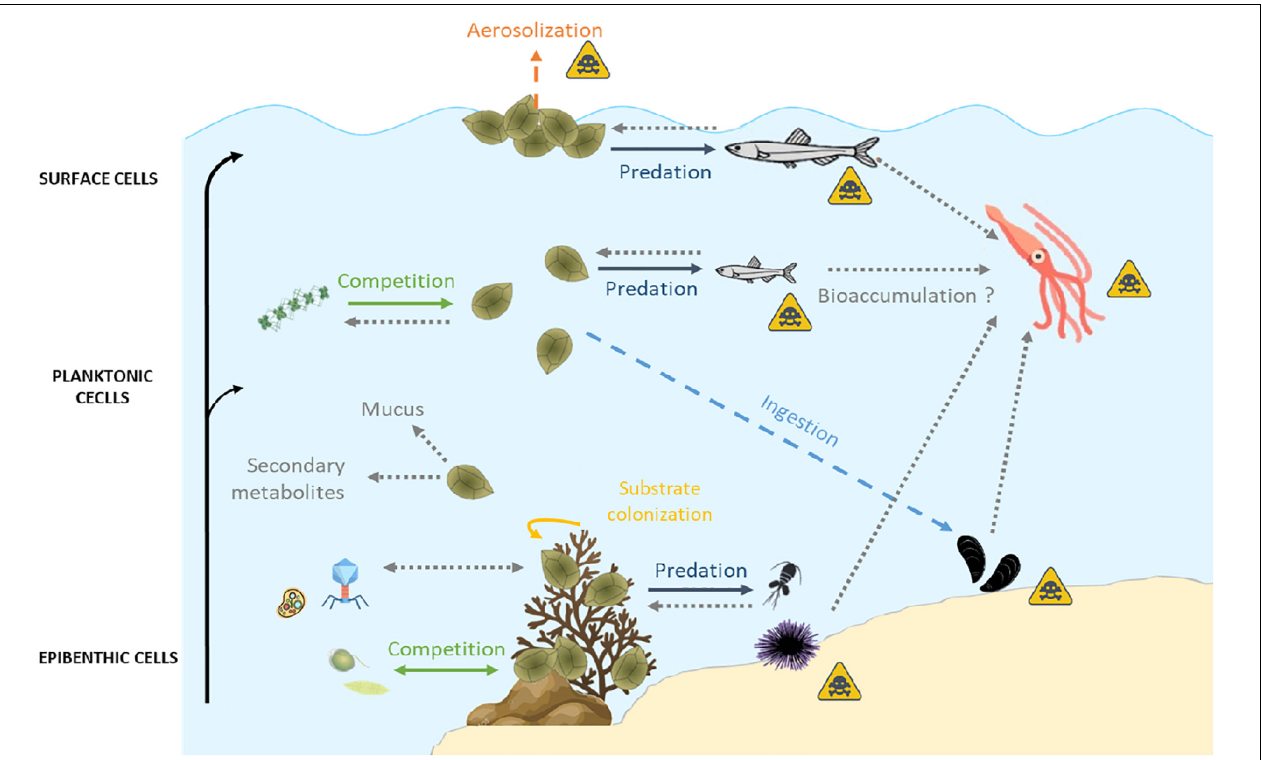
FIGURE 5 | Summary of biotic relationships between Ostreopsis spp. and its environment. Arrows in full lines represent the direct interactions, those in dashes represent the indirect interactions. Gray dotted arrows represent unknown interactions which could provide useful guidelines for future research studies. The yellow triangular symbol represents possible human poisoning pathways by toxins produced by Ostreopsis spp. Icons on this figure are copyrighted by